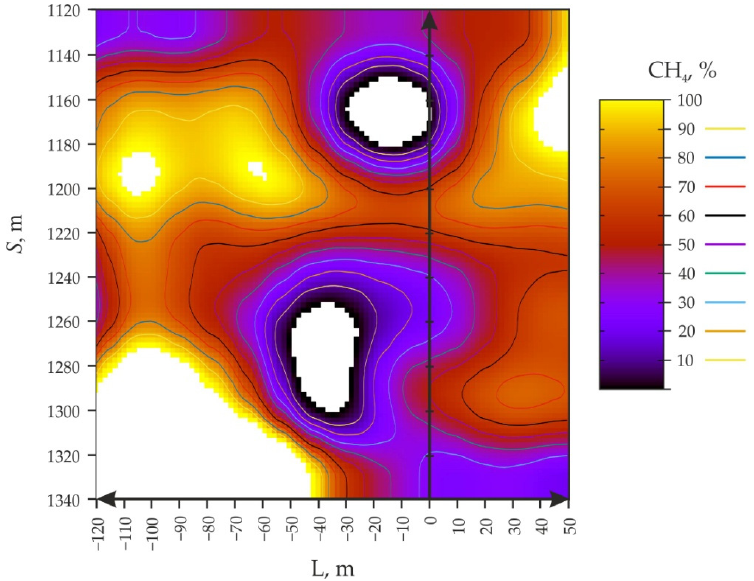
Figure 3. Evolution of the intensity of emission flows of coalmine methane during reverse mining of the m 3 seam (according to data from wells type No. 4).